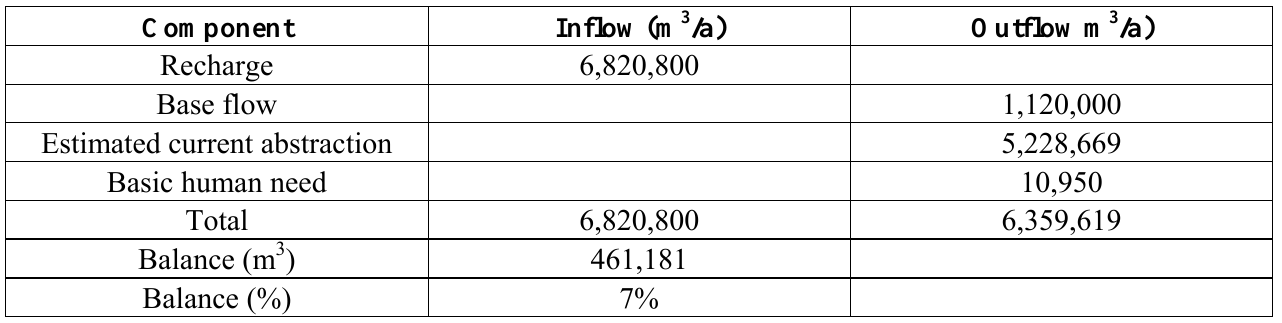
Table 6. Conceptual groundwater